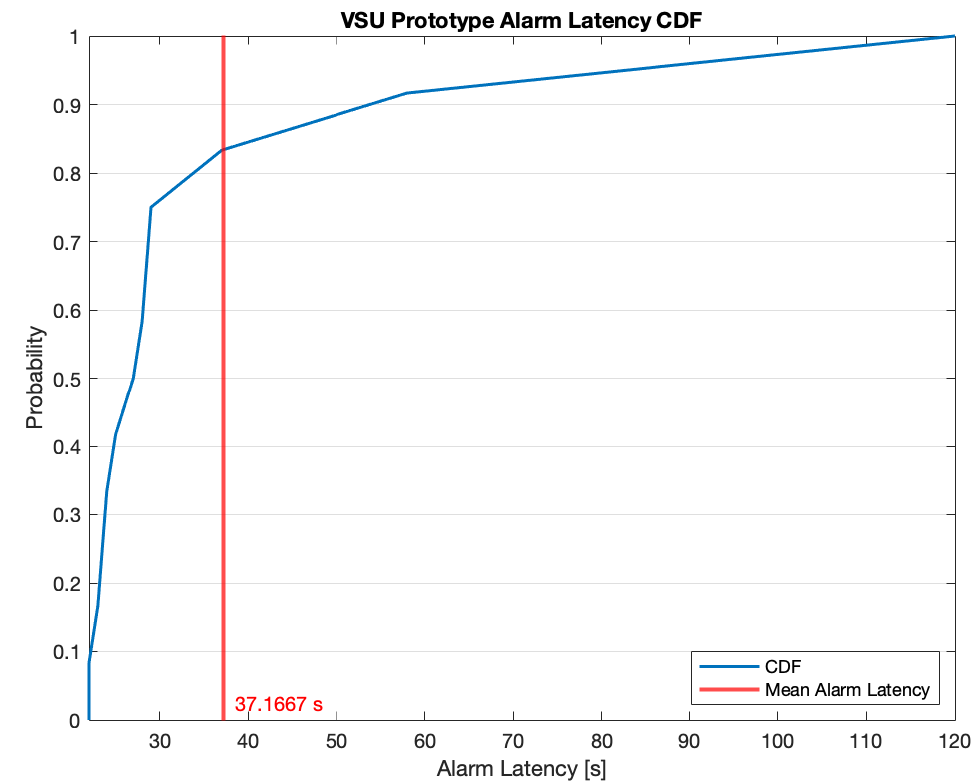
Figure 11. VSU prototype alarm latency